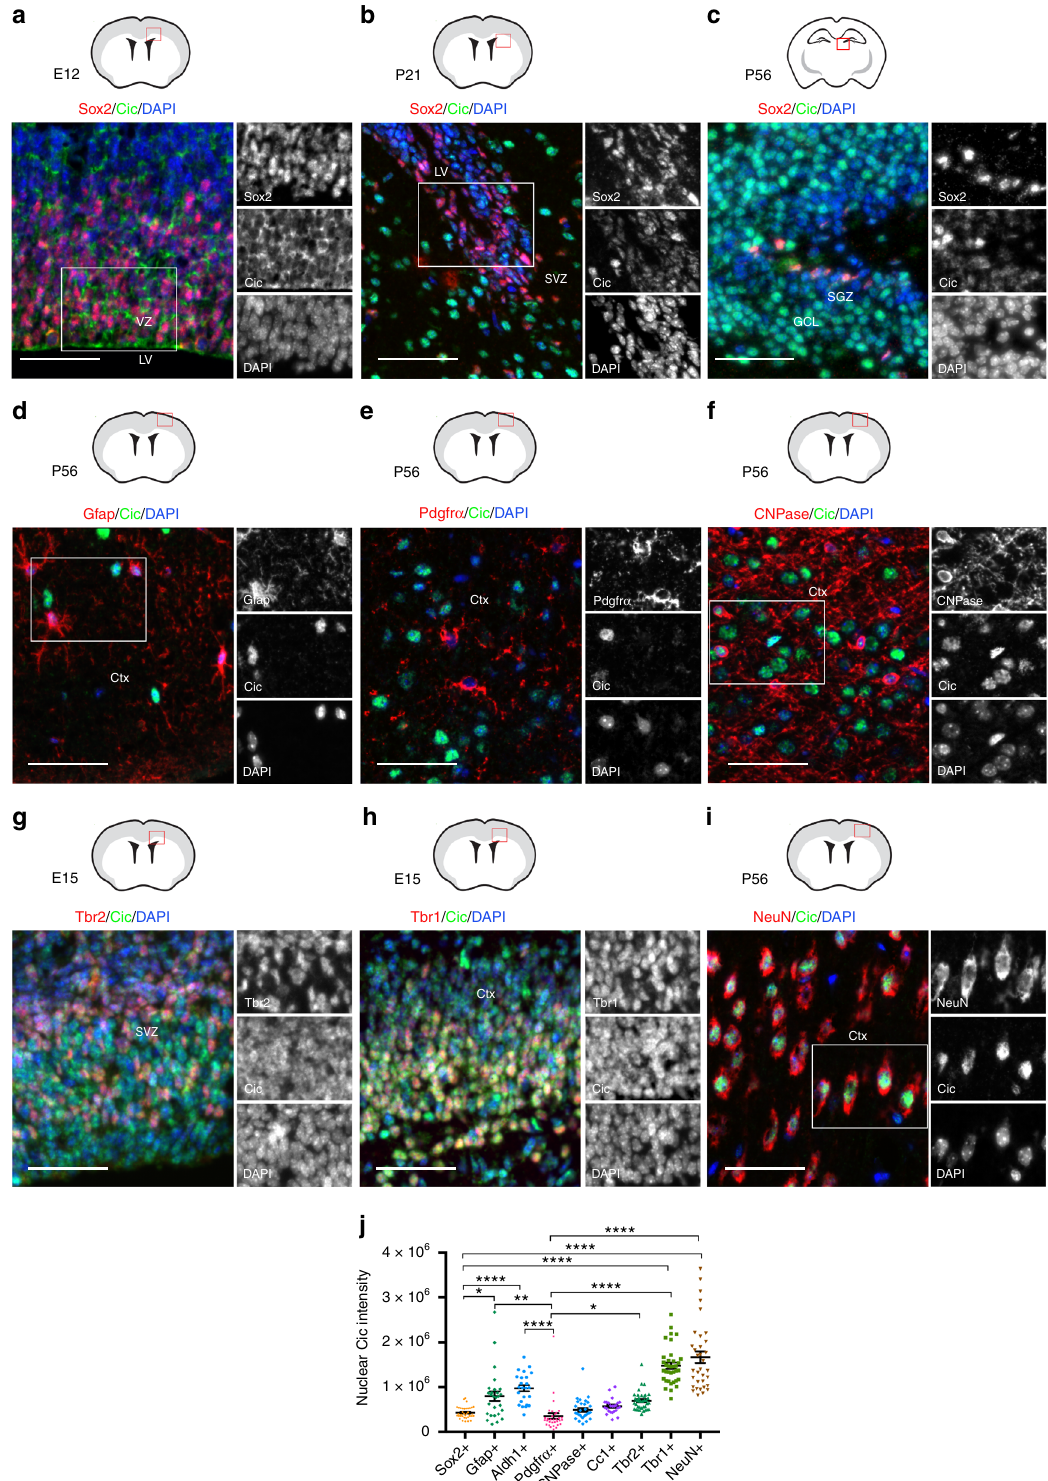
signi fi cantly increased (Fig. 2f, g) — a fi nding corroborated by increased Sox10 + (Fig. 2d, e). In oligodendroglial lineage progression, earlier stages were particularly increased, whereas later stages were decreased in Cic -null animals. Olig2 + Sox2 + cells and Olig2 + Pdgfra + OPCs were increased (Fig. 2f, g and Supplementary Fig. 3), whereas CNPase + immature oligoden- drocytes were decreased (Fig. 2f, g) in Cic -null animals. Mbp,